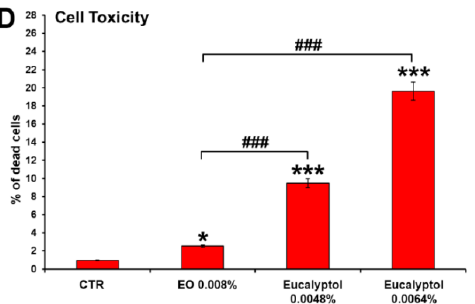
Figure 1. Comparative effects of Eucalyptus oil and 1,8-cineole (eucalyptol) treatments on phagocytic activity and viability of human MDMs. The phagocytic activity of treated and untreated MDMs was tested by adding to cultures 2 × 10 7 beads/mL of fluorescent polystyrene beads as described in Materials and Methods. ( A ) Confocal microscopy images, showing the beads uptake (yellow hue) in untreated control and MDMs treated for 24 h with Eucalyptus oil or eucalyptol, the latter used at concentrations equivalent to 60% and 80% (equal to 0.0048% and 0.0064% of eucalyptol, respectively) of the content of the dose used for the whole extract (0.008%); cell nuclei were counterstained with propidium iodide (red hue). Merged images with differential interference contrast, used to visualize cell morphology, are shown. Bar = 50 µm. ( B , C ) Quantitative assessment of MDM phagocytic activity obtained by counting the number of phagocytes ( B ), reported as percentage of phagocytic cells, as well as the number of beads per cell ( C ). A minimum of 200 cells/sample were analyzed and the results are the mean ± SD from three independent experiments ( n = 3). ( D ) Cell viability assay performed on MDMs cells after 24 h of EO and eucalyptol treatments by Trypan blue dye exclusion method; results, reported as a percentage of dead cells, are the mean ± SD from three independent experiments ( n = 3). ( B , C ) Significance (One-way ANOVA + Tukey multiple comparison test), * vs. CTR: * p < 0.05, ** p < 0.01, *** p < 0.001; # vs. EO: # p < 0.05, ### p < 0.001; ns: not significant.